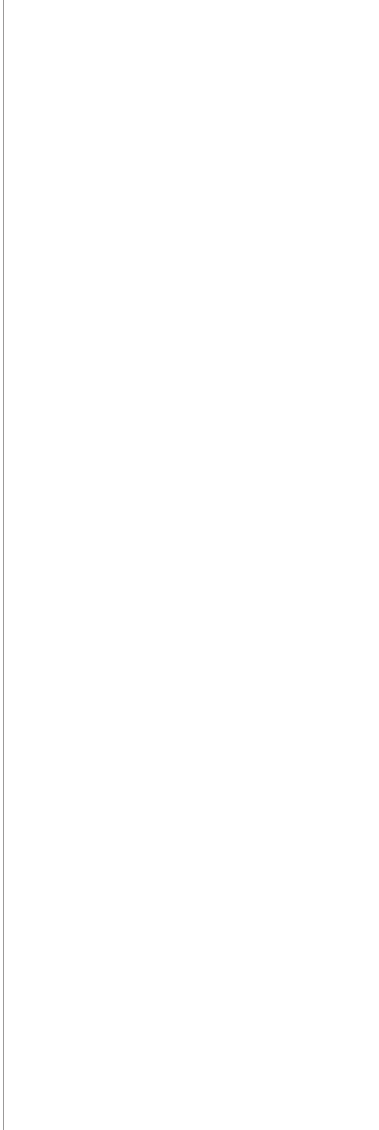
FIGURE 1 | Overall survival Kaplan – Meier survival curves of the cohort. (A) Overall survival curves strati fi ed by age in the total cohort after propensity score matching. (B) Overall survival curves strati fi ed by the reception of adjuvant chemotherapy in the patients aged 70 years and older. mOS, median overall